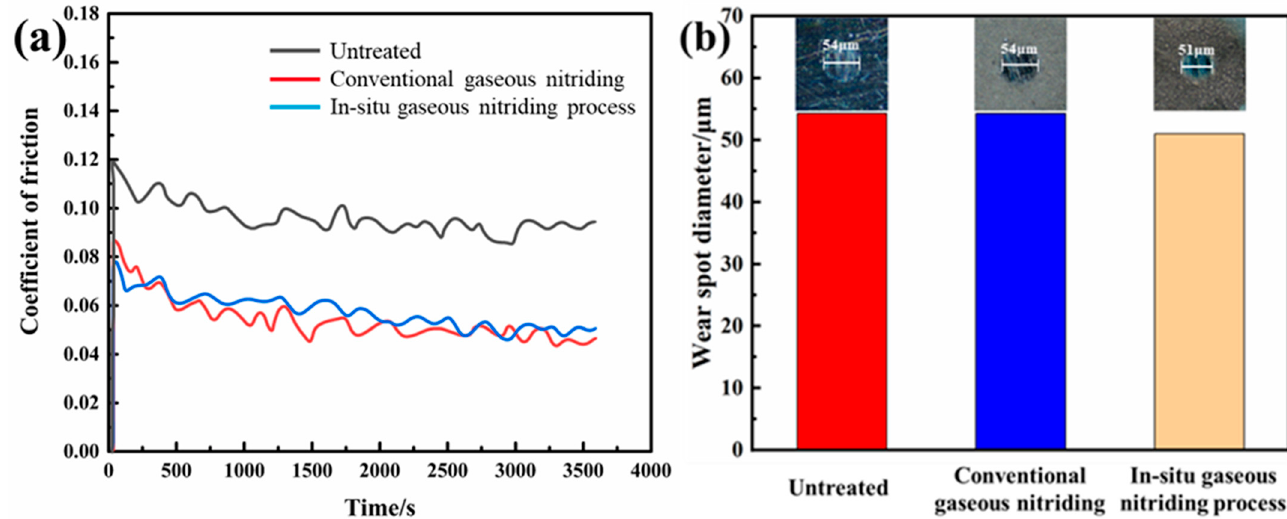
Figure 12. ( a ) The variation of friction coefficient with time. ( b ) Surface wear spot diameter of different treatment methods.